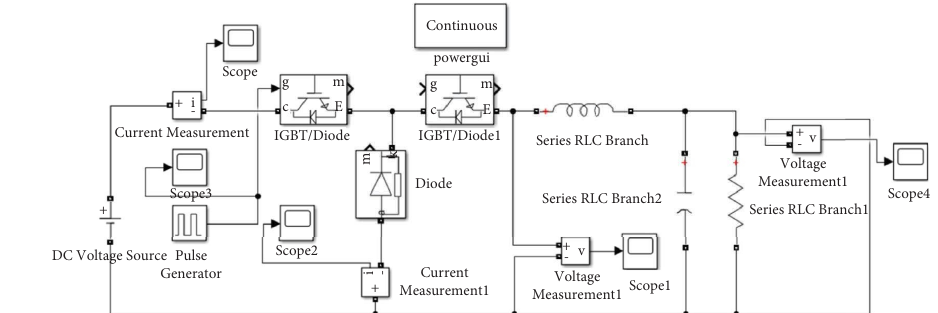
Figure 10: Simulation circuit diagram.